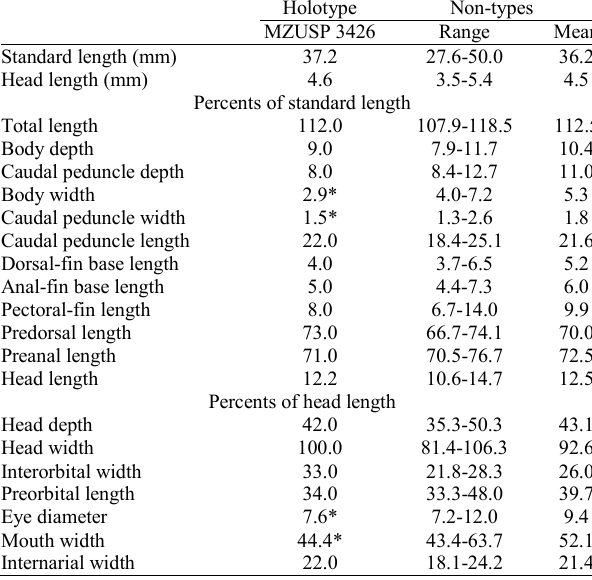
Table 1. Morphometric data of holotype and 26 additional specimens of Listrura camposi . Data of holotype from de Pinna (1988), except those indicated by